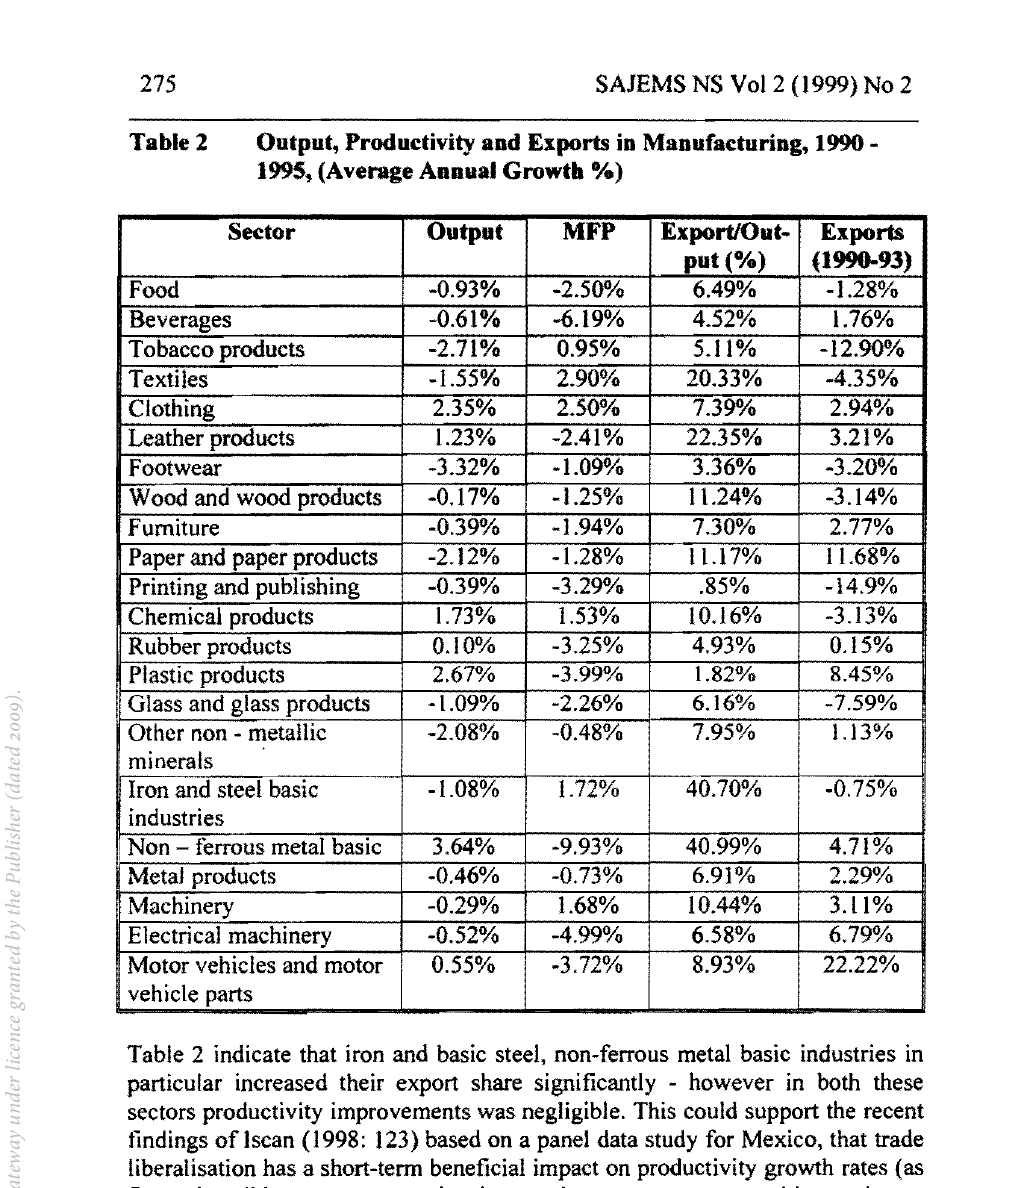
Output, Productivity and Exports in Manufacturing, 1990- 1995, (Average Annual Growth